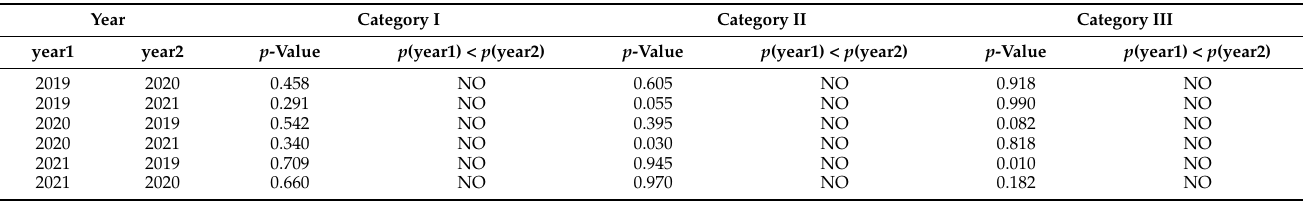
Table 2. Summary of proportion